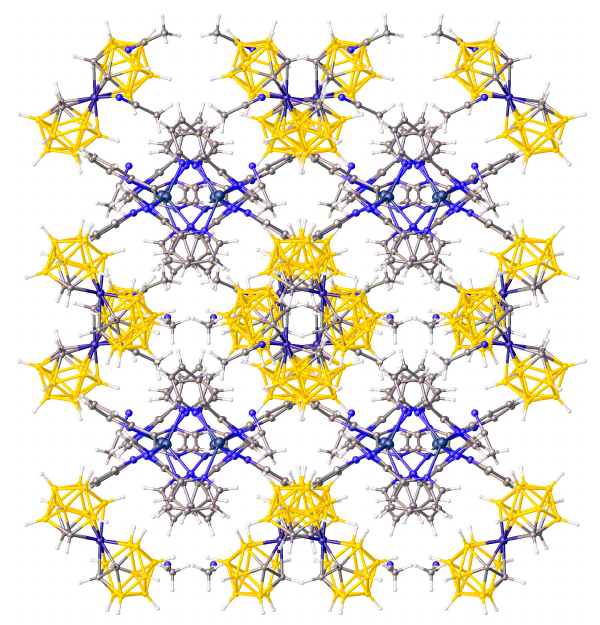
Figure 111. Crystal packing in X ray- structure of {[Ag 2 (bppz) 3 ][3,3’-Co(1,2-C 2 B 9 H 11 ) 2 ] 2 ·3.5(MeCN)} n. Complex {Ag(DABCO)[3,3’-Co(1,2-C 2 B 9 H 11 ) 2 ]} n was prepared by crystallization of Ag[3,3’-Co(1,2-C 2 B 9 H 11 ) 2 ] from acetonitrile in the presence of 1,4-diazabicyclo[2.2.2]octane [77]. The silver